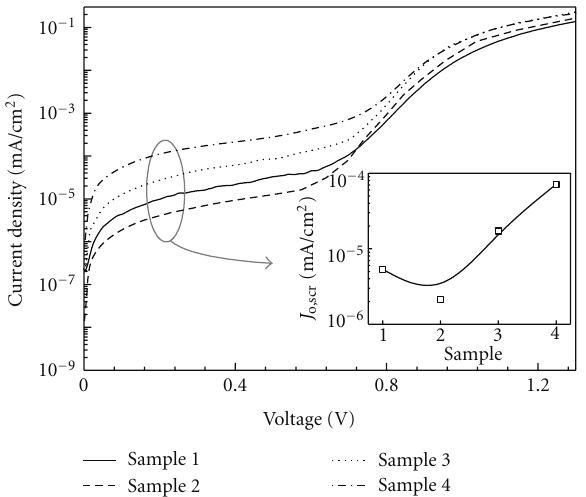
Figure 5: Far forward bias dark J - V characteristics for a-Si thin film solar cells at various B 2 H 6 flow rates.